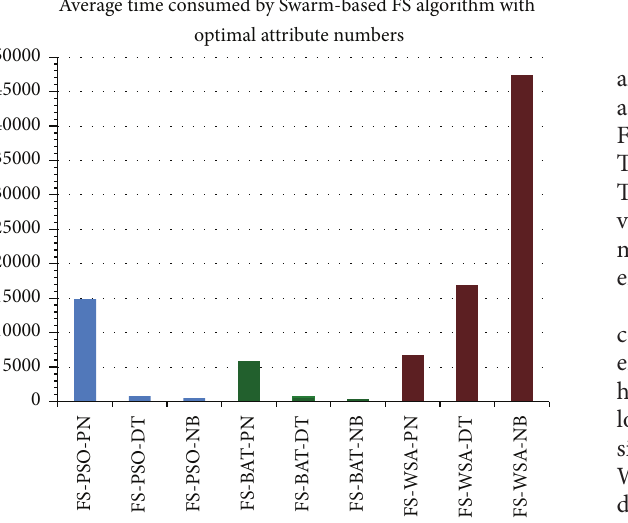
Figure 14: Comparison of different Swarm-based FS algorithms with optimal features in consumed time.